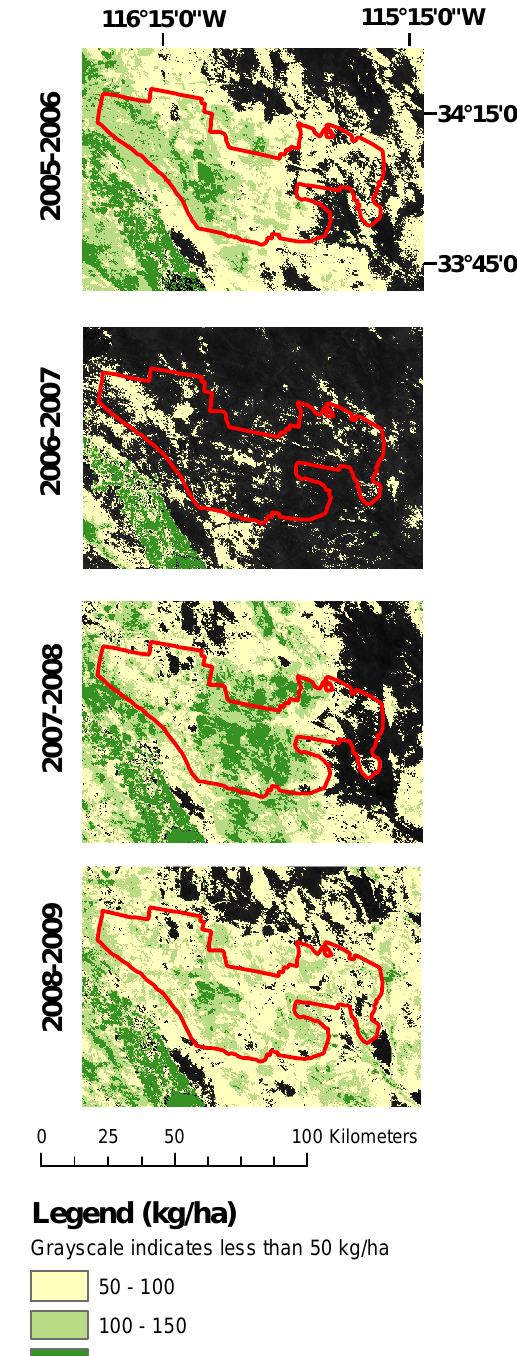
Figure 5. Joshua Tree National Park peak winter annual above ground biomass, estimated as a function of 8-day MODIS NDVI over the 10th percentile from winter 2000–2001 through winter 2008–2009. The red line indicates the boundary of Joshua Tree National Park. Differences in both spatial and temporal distribution of winter annual biomass illustrate the value of using satellite-based maps of winter annual biomass. Black or grayscale areas represent less than 50 kg/ha above ground